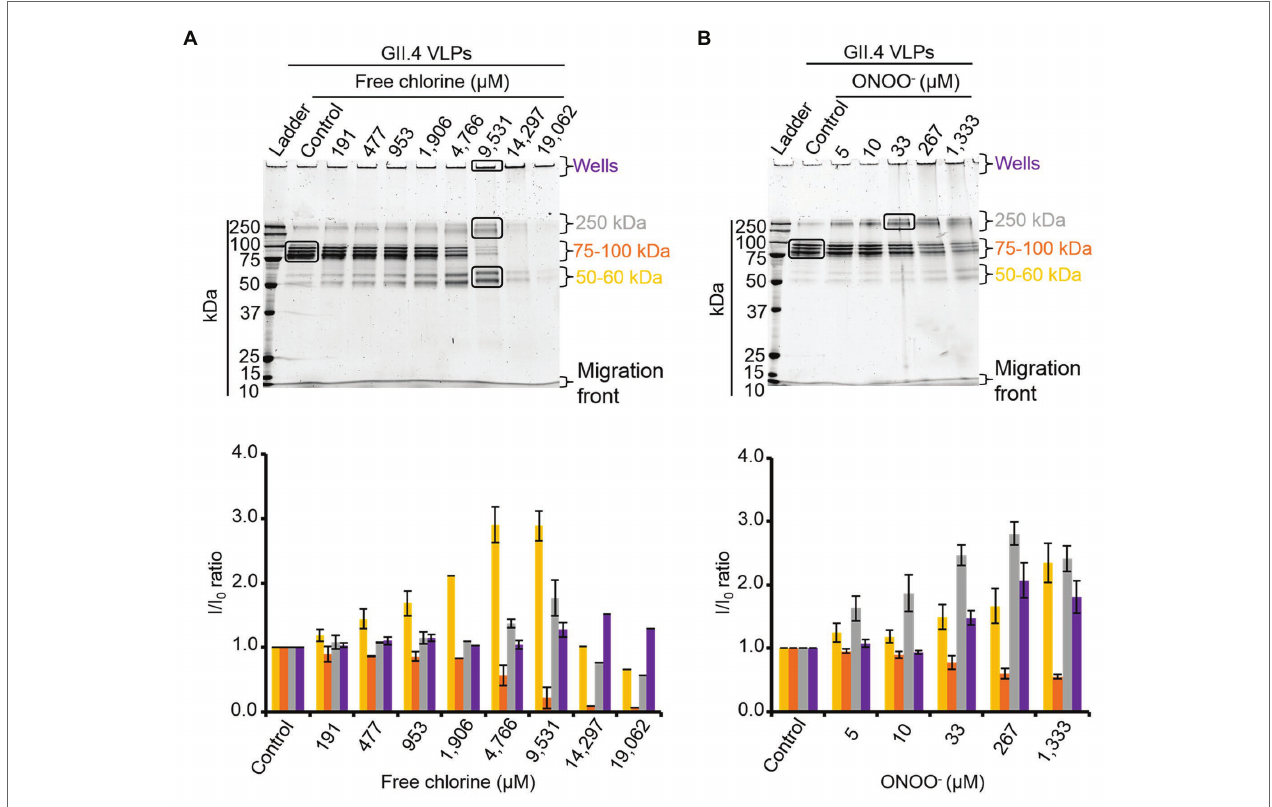
FIGURE 2 | Free chlorine and ONOO − modify the capsid proteins of GII.4 VLPs. GII.4 VLPs were analyzed using SDS-PAGE following treatment with free chlorine (A) or ONOO − (B) without heat treatment. The variation in intensity of protein bands obtained using SDS-PAGE gel was measured for both oxidative treatments (see the histograms placed below the gels of the respective conditions). The intensity of protein bands (I/I 0 ratio) was determined by dividing the mean intensity value of each band obtained at a specific molecular weight following oxidative treatment (I) by the mean intensity value of the same band obtained in the untreated control (I 0 ). Each data point is an average of three independent experiments conducted on different days (except for VLPs treated with free chlorine at final concentrations of 14,297 and 19,062 μ M, for which one replication was performed). The intensity of protein bands was separated into groups, as indicated by the color code on the right-hand side of the gels (50–60 kDa, 75–100 kDa, and 250 kDa, and the wells are in yellow, orange, gray, and violet, respectively). Error bars indicate standard deviations. Black rectangles on SDS-PAGE gels correspond to the protein bands that were analyzed using